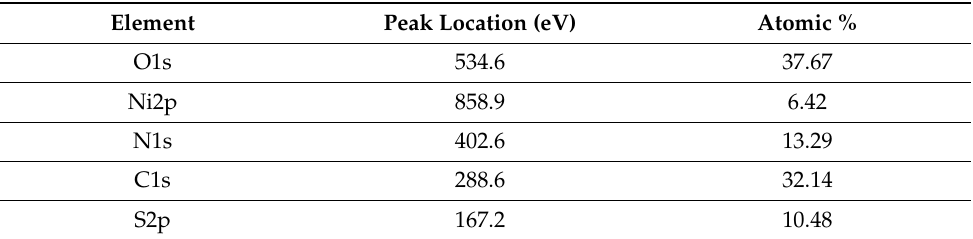
Table 1. Peak location and atomic percent for each element in the composite NiS-NiO/G-C3N4 calculated from XPS